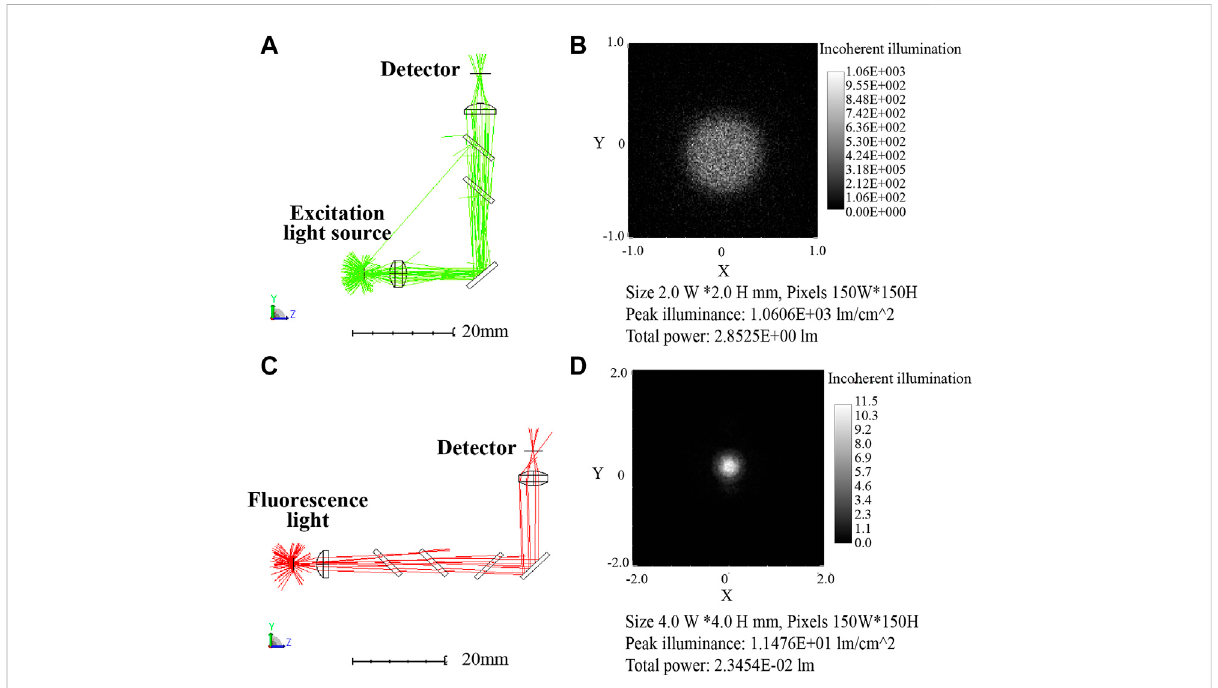
FIGURE 7 Second channel optical path (excitation/emission: 570 nm/630 nm) simulation diagram. (A) 3D layout of the excitation optical path with 2.85 l m total power. (B) Image of the excitation optical path detector. (C) 3D layout of the emission optical path. (D) Image of the emission optical path detector with 2.35 × 10 -2 lm total power.